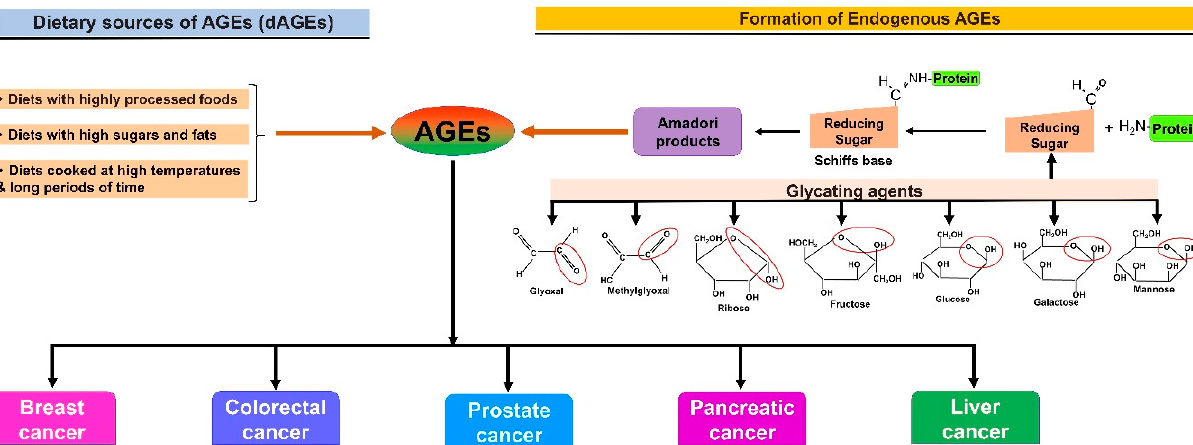
Figure 1. The mechanism of the formation of advanced glycation end products (AGEs): Glycation of proteins is mediated by the reaction between amino ( ‐ NH 2 ) groups of amino acids, especially lysine residues, and the carbonyl group of sugars ( ‐ CR=O or –CH=O), leading to the generation of products through the Maillard reaction. The generated Maillard reaction products subsequently undergo Amadori rearrangement to form advanced glycation end products (AGEs) that are implicated in cancer progression.